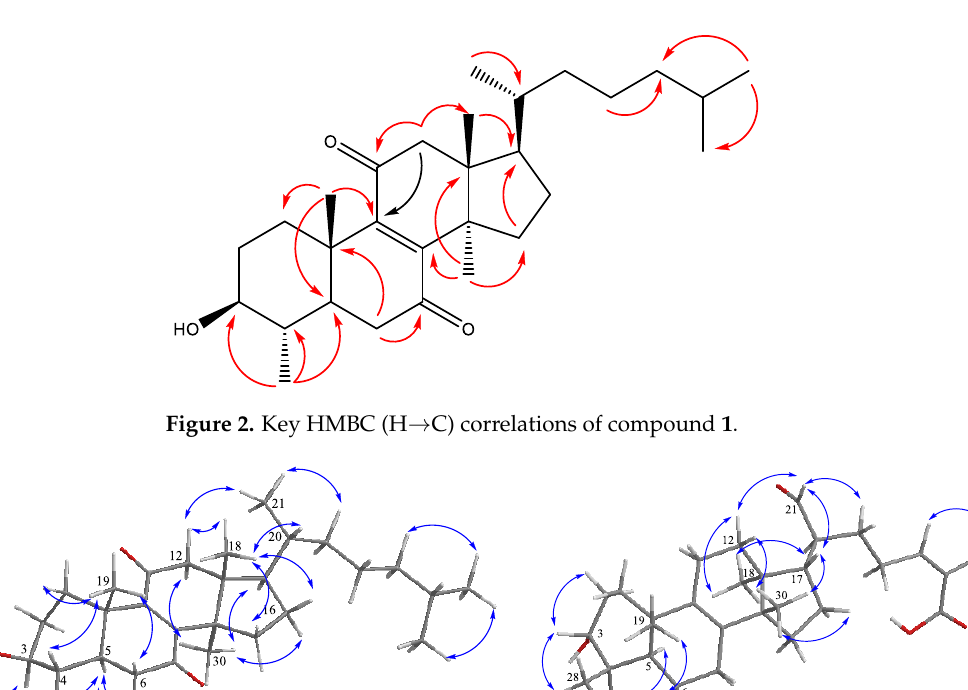
H 3 -18/H-20, H 3 -18/H-12 β , H 3 -19/H-4 and H 3 -19/H-6 β were observed and used to assign